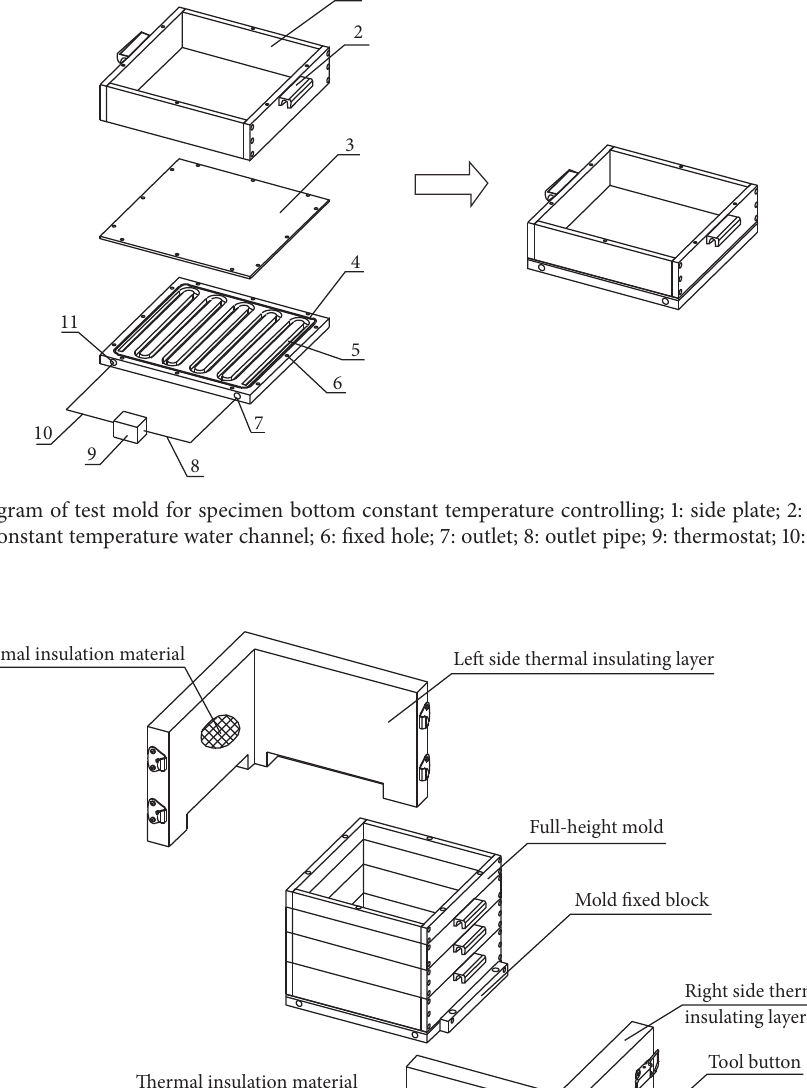
transfers heat to the sealing cover plate and thus the specimen bottom temperature is controlled. More details about the mold are shown in Figure